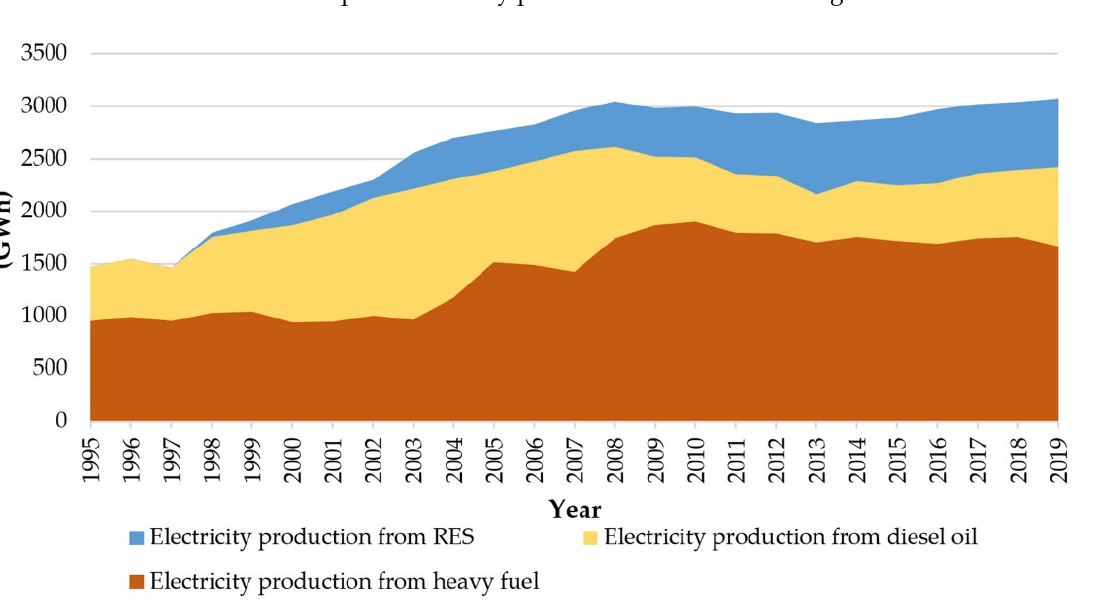
Figure 8. Evolution of the annual electricity production in Crete from the involved energy resources (1995–2019) [50]. (1995–2019)